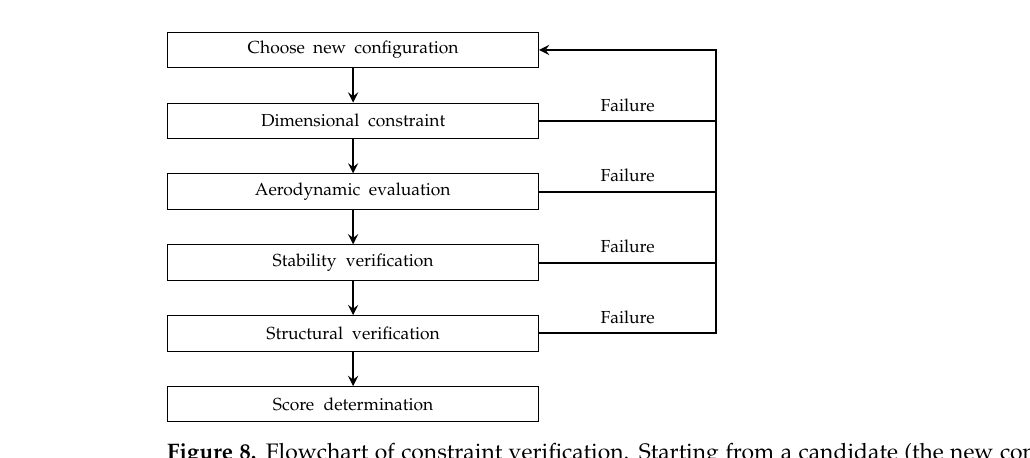
Figure 8. Flowchart of constraint verification. Starting from a candidate (the new configuration), different constraints are verified in sequence. If any constraint is not satisfied, a new candidate is selected.